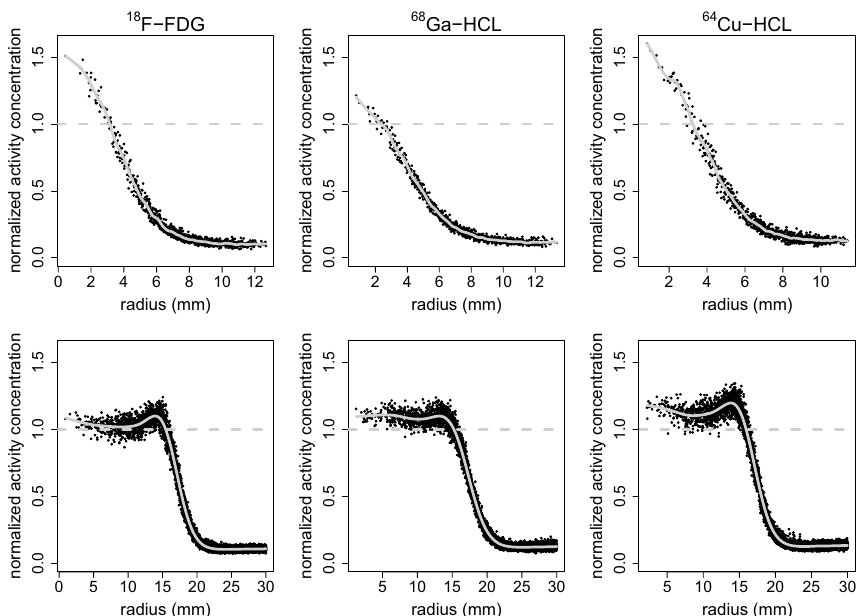
Fig. 4 Radial profile of the normalized activity concentration of spheres filled with 18 F-FDG, 68 Ga-HCl, or 64 Cu-HCl. Radial profile of the ratio of measured and true activity concentration of the smallest sphere (upper row; diameter 10 mm) and largest sphere (lower row; diameter 37 mm) of the NEMA PET body phantom filled with 18 F-FDG, 68 Ga-HCl, or 64 Cu-HCl (from left to right) at a sphere-to-background activity concentration ratio of 8:1 without the simulation of an obese patient (normal weight setup). The solid line represents the least-squares fit of the convolution of the point spread function and the object geometry, analyzed to yield the FWHM. To guide the eye, the dashed lines represent a mean ratio of measured and actual activity concentrations of